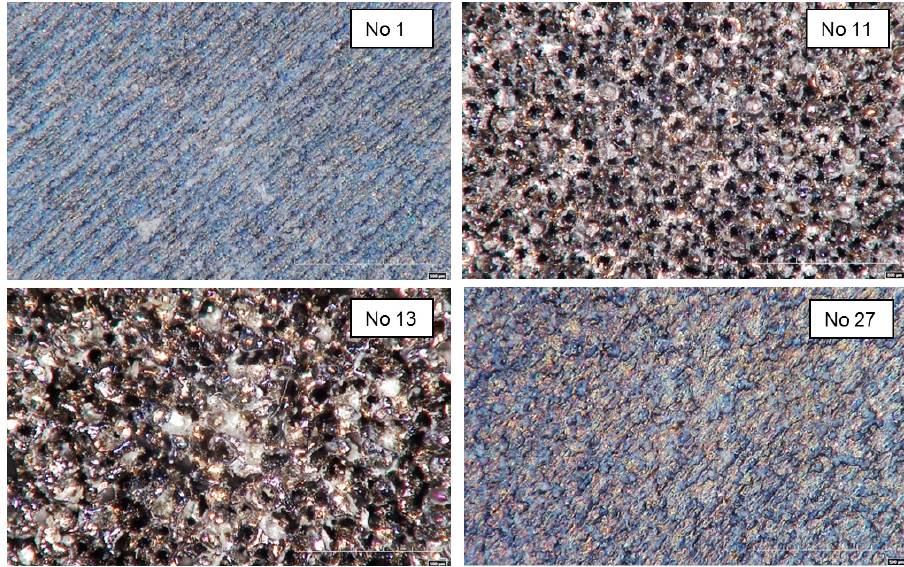
Figure 6. Microscope Images of several laser milled surfaces.